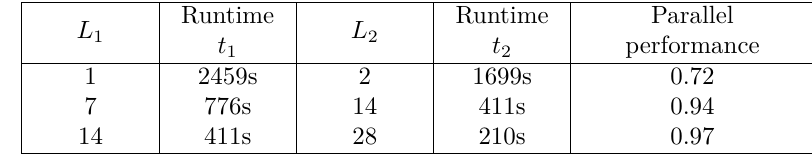
Table 7: Runtime and Parallel performance of the attack on ECDLP. Results are based on 100 runs per L . i ∈ L